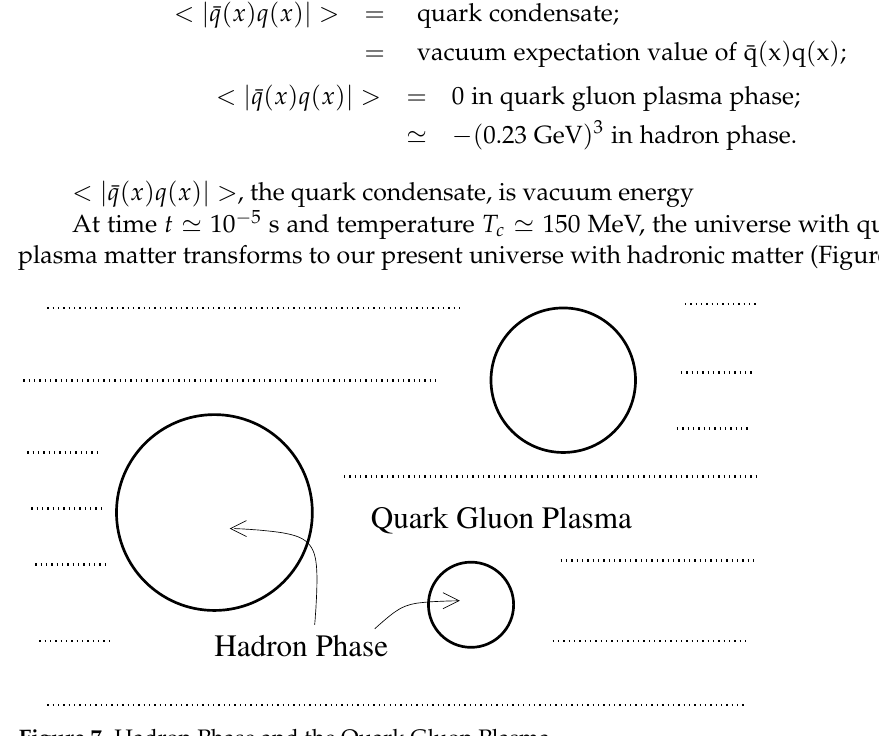
Figure 7. Hadron Phase and the Quark Gluon